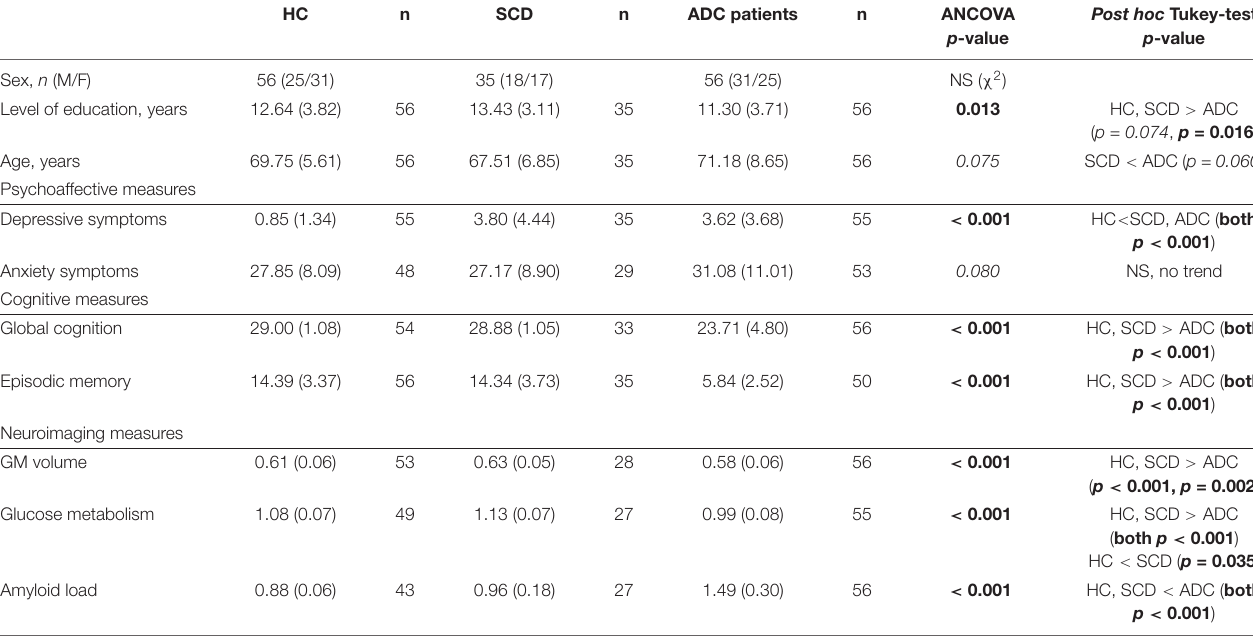
TABLE 1 | Study sample